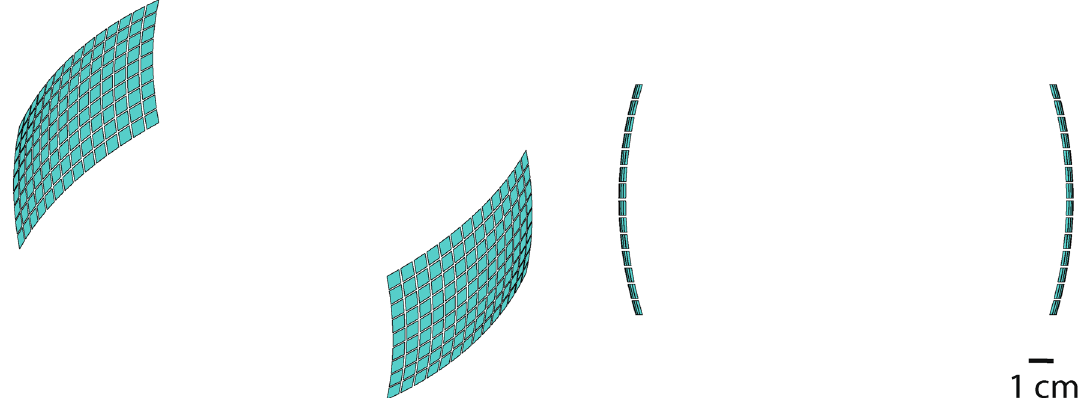
Figure 6. Array geometry. Schematic of the arrays used in the simulations and implemented in hardware. Each square corresponds to an array